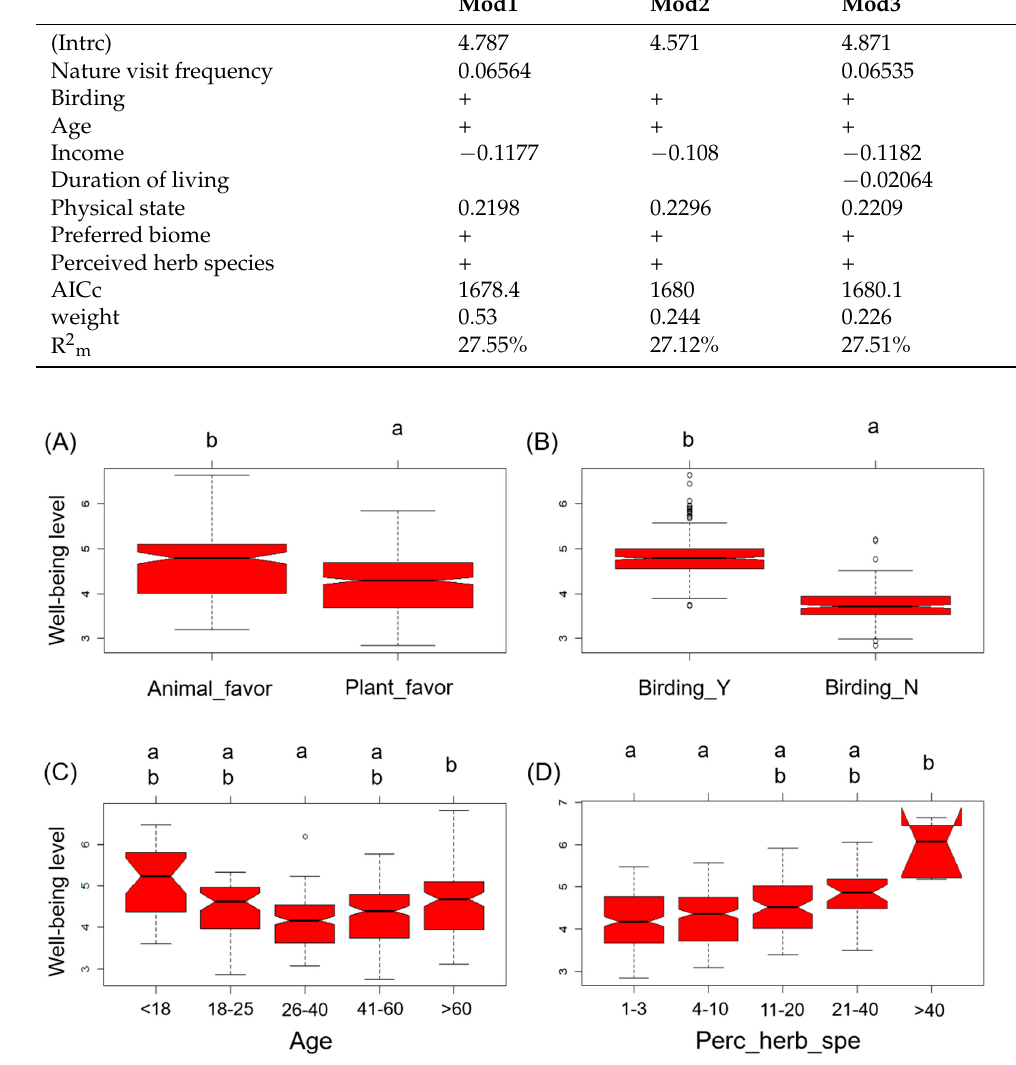
Figure 3. Predicted psychological well-being under different levels of the four key categorical variables. Different lowercase letters represent for different effect levels, and significant difference only occurred between the single letters ‘a’ and ‘b’. Panels: comparisons between ( A ) people who prefer animals and plants within their neighborhood, ( B ) residents with (Birding_Y) and without (Birding_N) bird watching experience, ( C ) residents in different age intervals (here presented as the original intervals in our questionnaire), and ( D ) residents who perceived different number of grass species (here presented as the original intervals in our questionnaire) within their living spaces. Table 2. Results of model selection analysis for residents’ psychological health based on AICc criterion. All the models are very significant ( p < 0.01) with a marginal R 2 ranging from 0.2712 to 0.2755. The ‘+’ stand for the significant effects of categorical variables. For descriptions for predictive variables, please see Table 1.